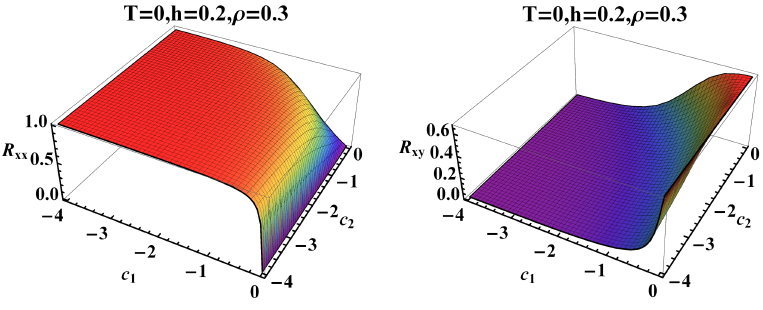
Figure 2 . The influence of c 1 and c 2 on R xx and R xy . We take T = 0 and ρ = 0 . 3 , h = 0 . 2 as an example.